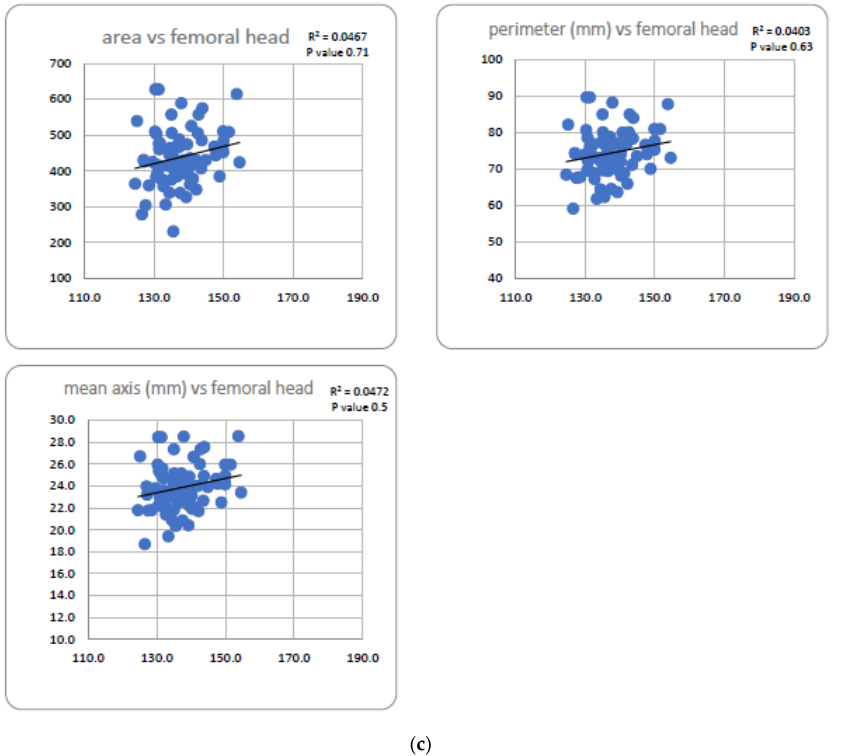
Figure 6. ( a ) Correlations of parameters of the aortic annulus (vertical axis) versus mean femoral head perimeter (in mm, horizontal axis) among the total study population (n = 139); ( b ) Correla- tions of parameters of the aortic annulus (vertical axis) versus mean femoral head perimeter (in mm, horizontal axis) among males (n = 63). Aortic Annulus area (mm 2 ) = 3.26 * femoral head pe- rimeter (mm) + 22.5; Aortic Annulus perimeter (mm) = 0.46 * femoral head perimeter (mm) + 10.2; Aortic Annulus mean axis (mm) = 0.15 * femoral head perimeter (mm) + 3; ( c )Correlations of pa- rameters of the aortic annulus (vertical axis) versus mean femoral head perimeter (in mm, hori- zontal axis) among females (n = 76).